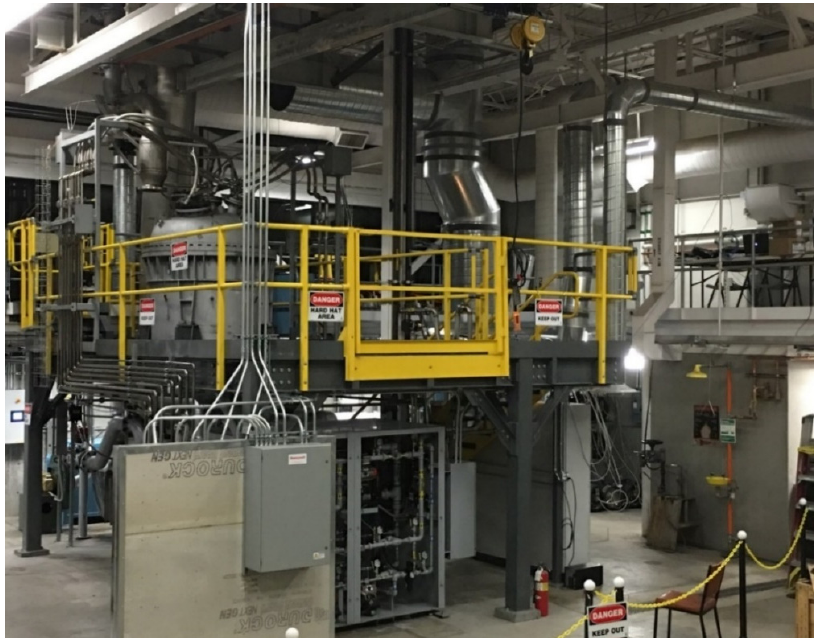
Figure 3. The pilot plant with a flash reactor installed at the University of Utah.